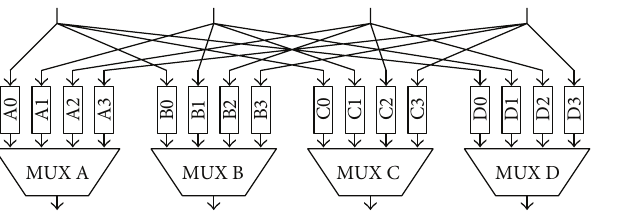
Figure 7: Fully connected interconnect network.